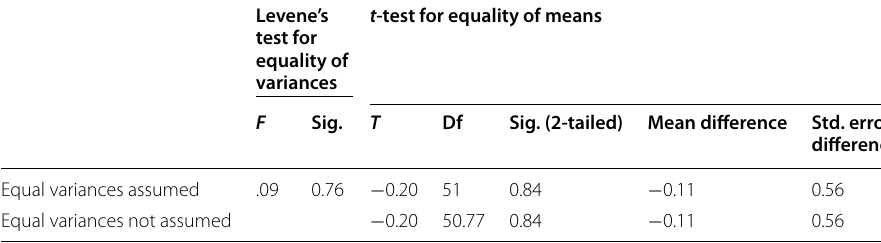
Table 2 Inferential statistics (speaking pretest of both groups)